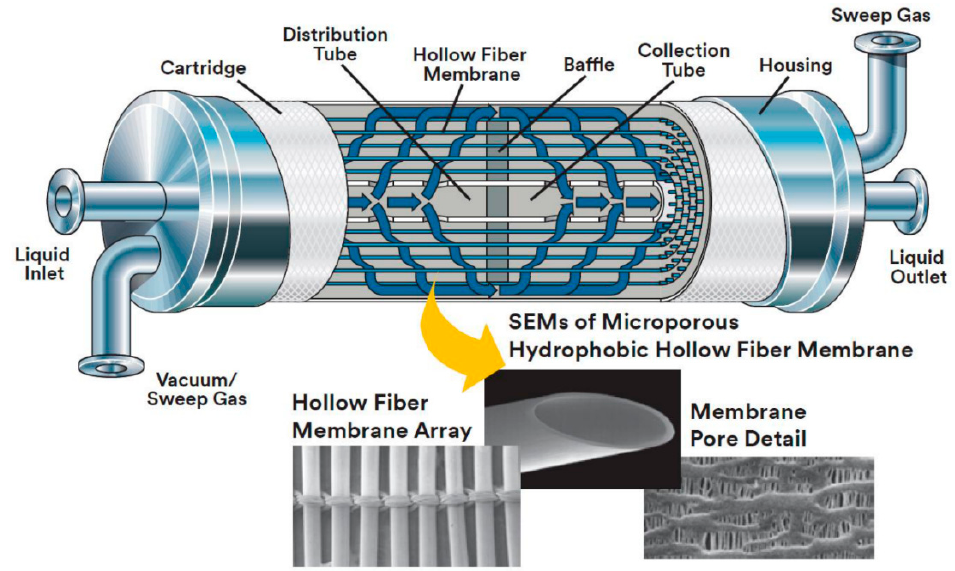
Figure 4. 3M™ Liqui-Cel™ EXF membrane contactor module (Reprinted from [37]).